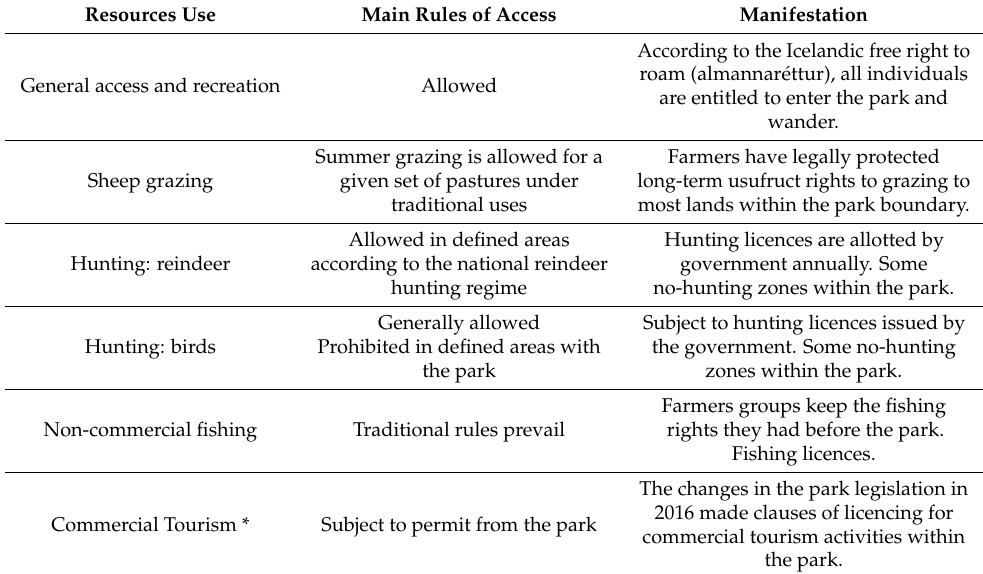
Table 3. Main rules of access and resource use within the